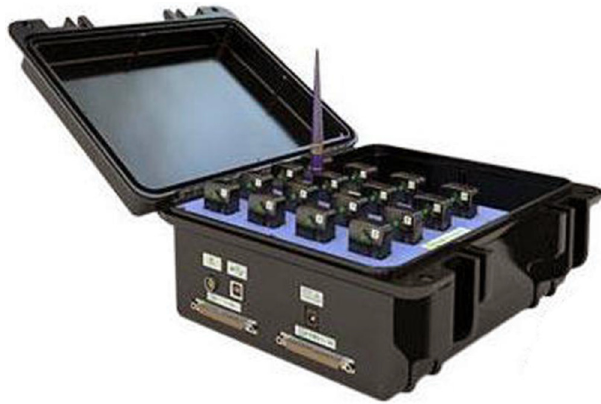
Fig. 1. Delsys EMG acquisition system.